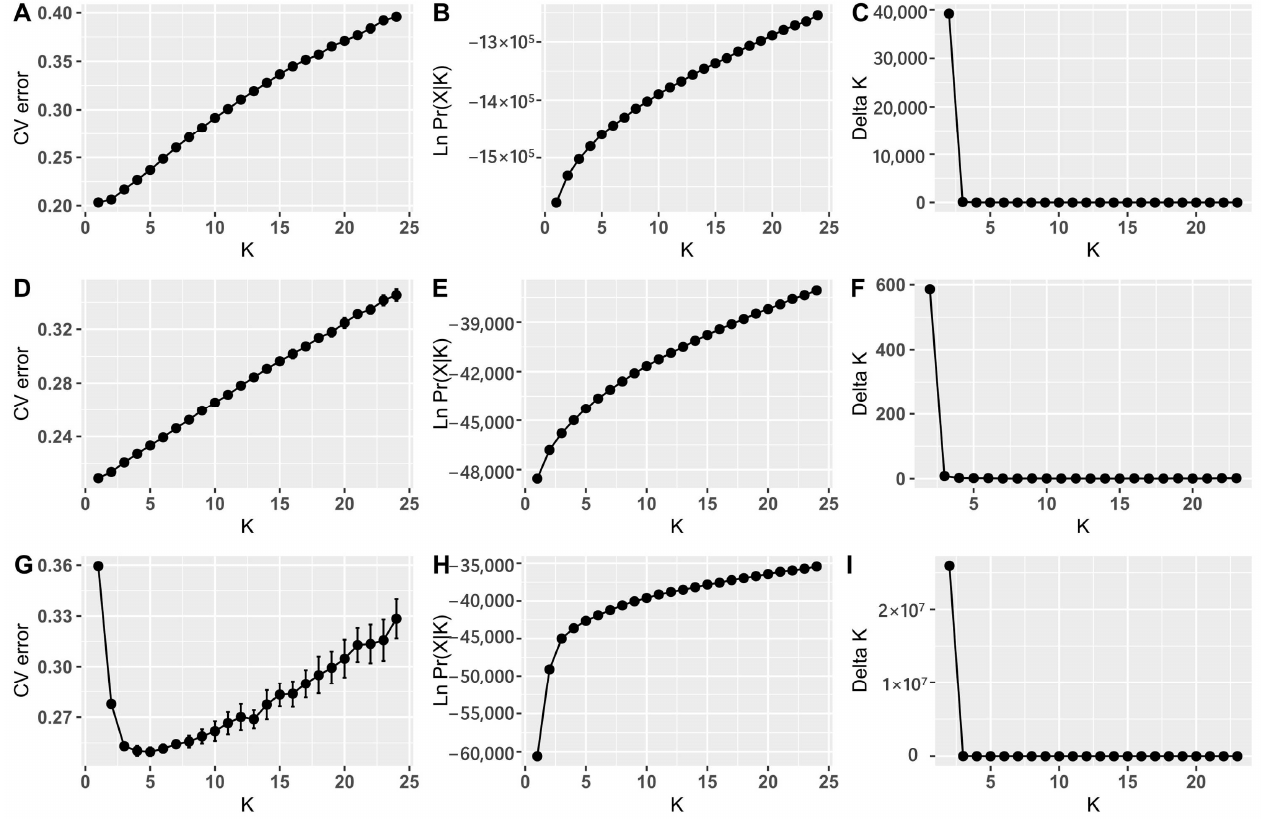
Figure 7. Graphs displaying the results of analysis of probable number of clusters K . Cross-validation prediction error, log likelihood and Δ K values for each K based on all 25,143 SNPs ( A – C ), 761 neutral SNPs ( D – F ) and 550 adaptive SNPs ( G – I ).